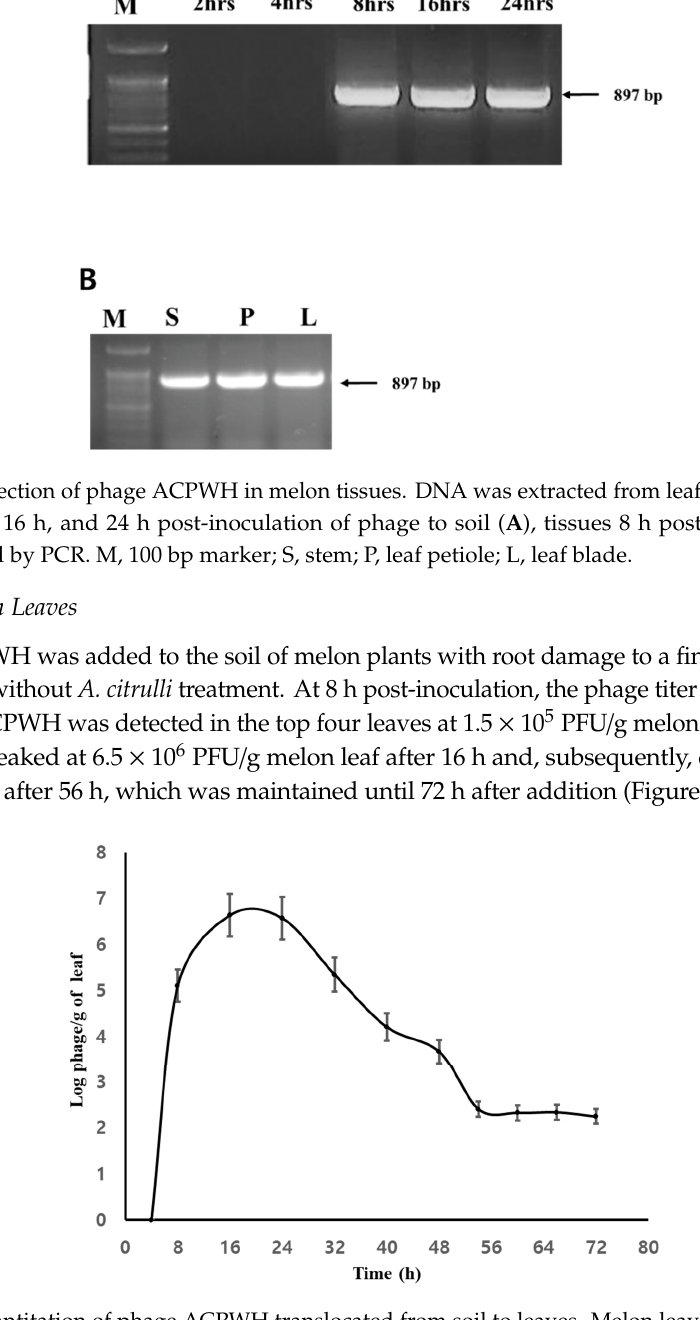
Figure 2. Quantitation of phage ACPWH translocated from soil to leaves. Melon leaves were collected every 8 h after addition of phage to soil and subjected to plaque assay. The results are means of three replications; vertical lines are standard deviations.